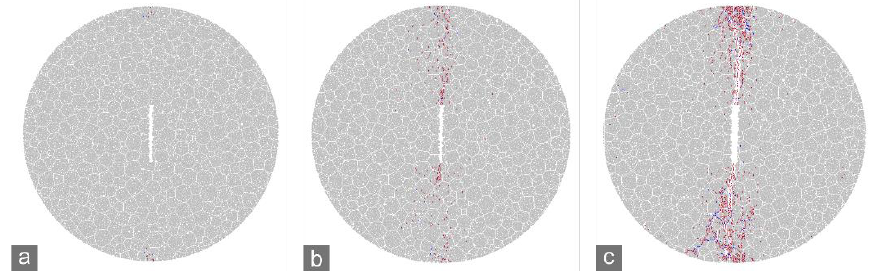
Figure 10. Simulated cracking process of marble A CCNBD specimen. ( a ) Cracking initiation at notched crack tips (~66% P max ); ( b ) reaching P max ; ( c ) specimen rupture.